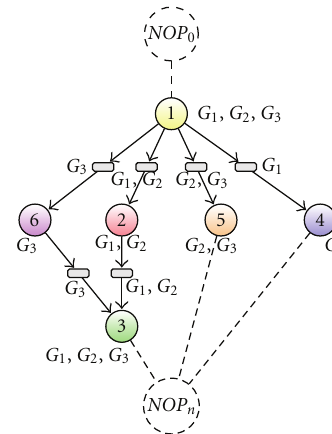
v = NOP Figure 5: Example of the merge graph of the data flow graphs G 1 , 0 0 is used G G 2 , and 3 from Figure 4. Each node of the merge graph holds a reference to the data flow graph it is a part